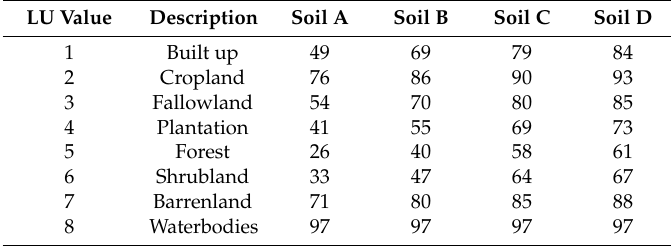
Figure 7. Curve number map of the study area for the year 2014. Table 6. Curve number look-up table for each land cover type with the type of soil. LU